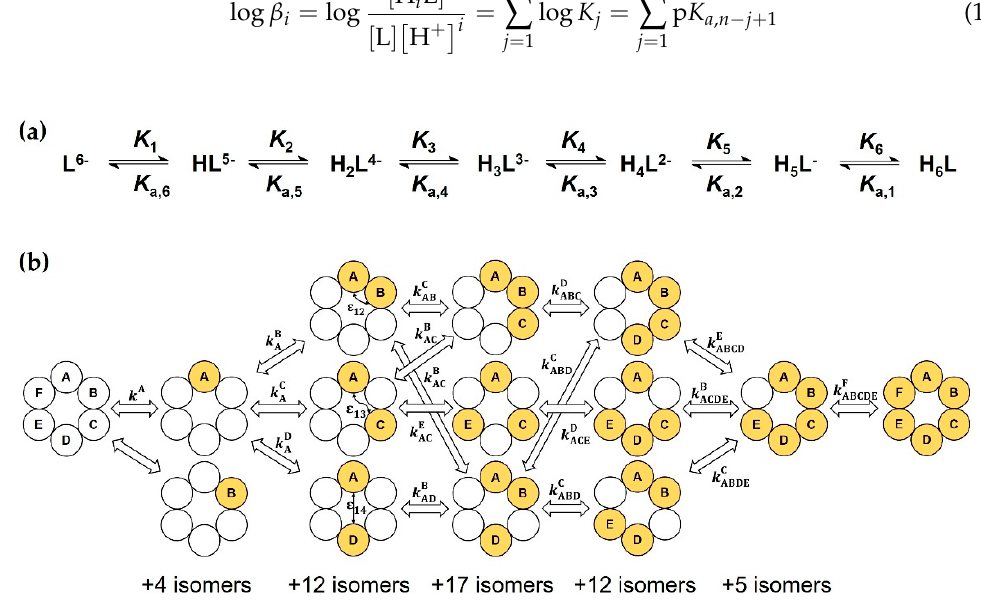
Figure 4. ( a ) Macroscopic protonation equilibria of Su α -CD, with protonation and dissociation macroconstants; ( b ) excerpt of the complete microscopic protonation scheme of Su α -CD. For each mi- crospecies, empty circles symbolize the A, B, . . . F carboxylate sites in unprotonated form, while filled circles in protonated state. Microconstants k x y and pair interactivity parameters ε ij are also